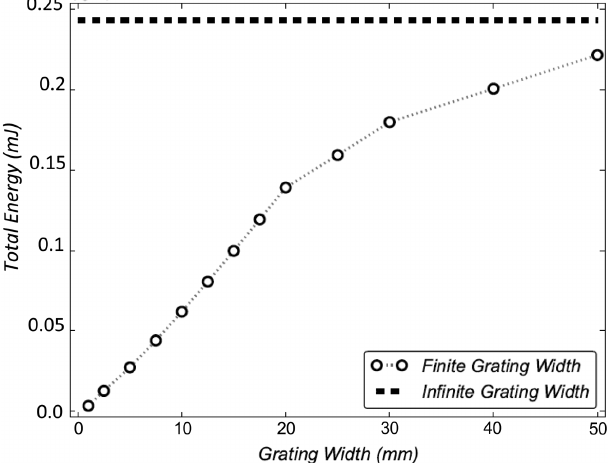
FIG. 6. Comparison of the signal intensity from the gratings of infinite (dashed line) and finite (dotted line)